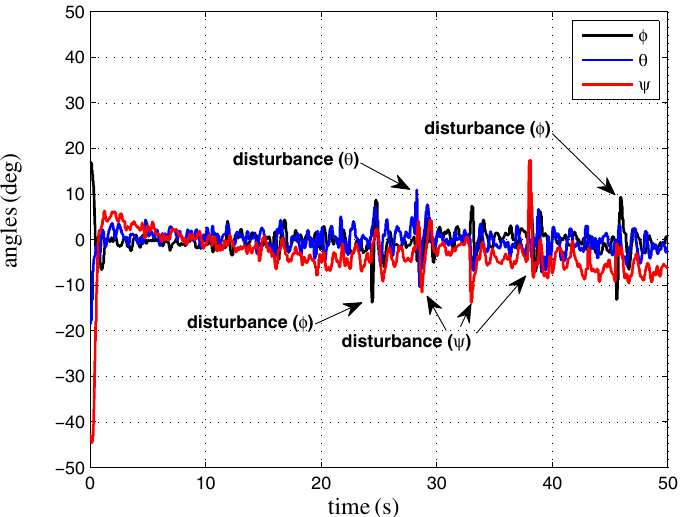
Figure 6. Control law of Corollary 1: the evolution of the roll, pitch and yaw